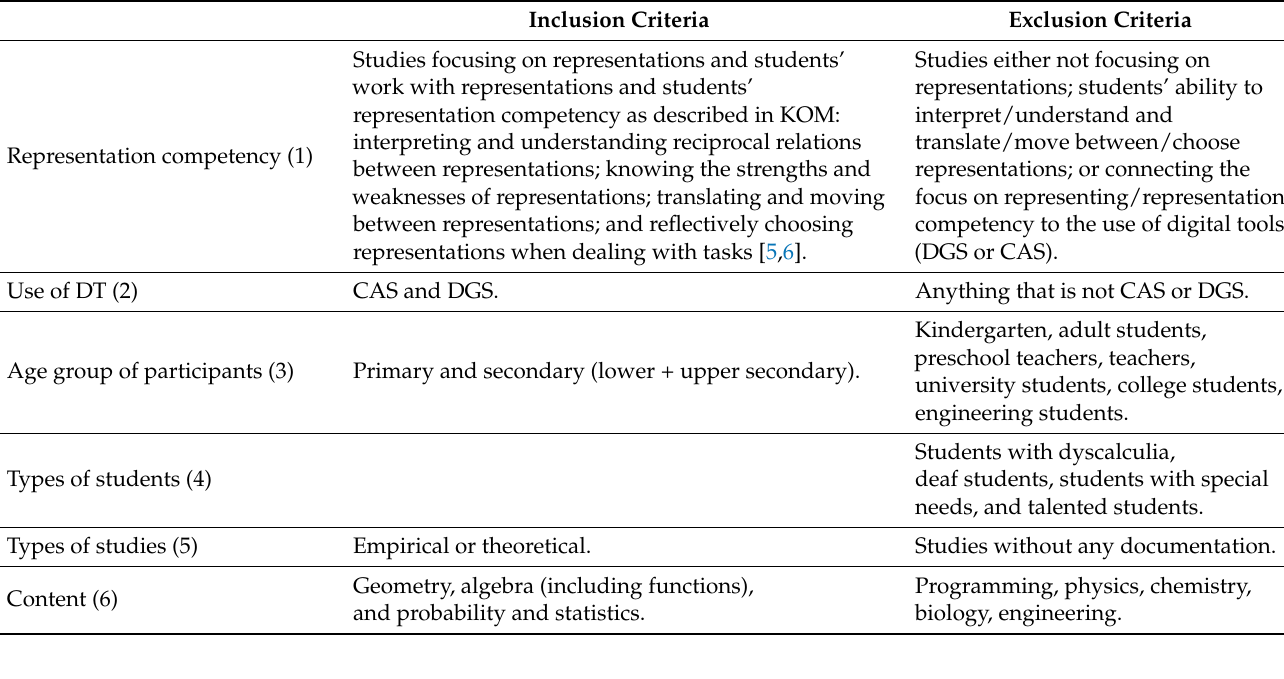
Table 1. Summary of inclusion and exclusion criteria for our review.